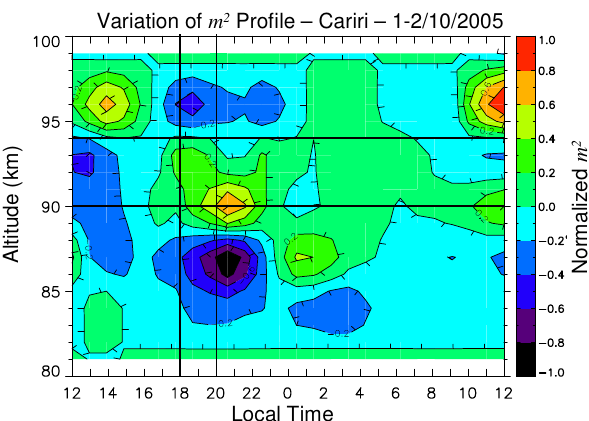
Fig. 5. Contours of normalized m 2 between 12:00(LT) of 1 October 2005, and 12:00(LT) of 2 October 2005, over S˜ao Jo˜ao do Cariri. The vertical solid lines indicate the observation time of the wave front and the horizontal solid lines delimit the top and bottom of the